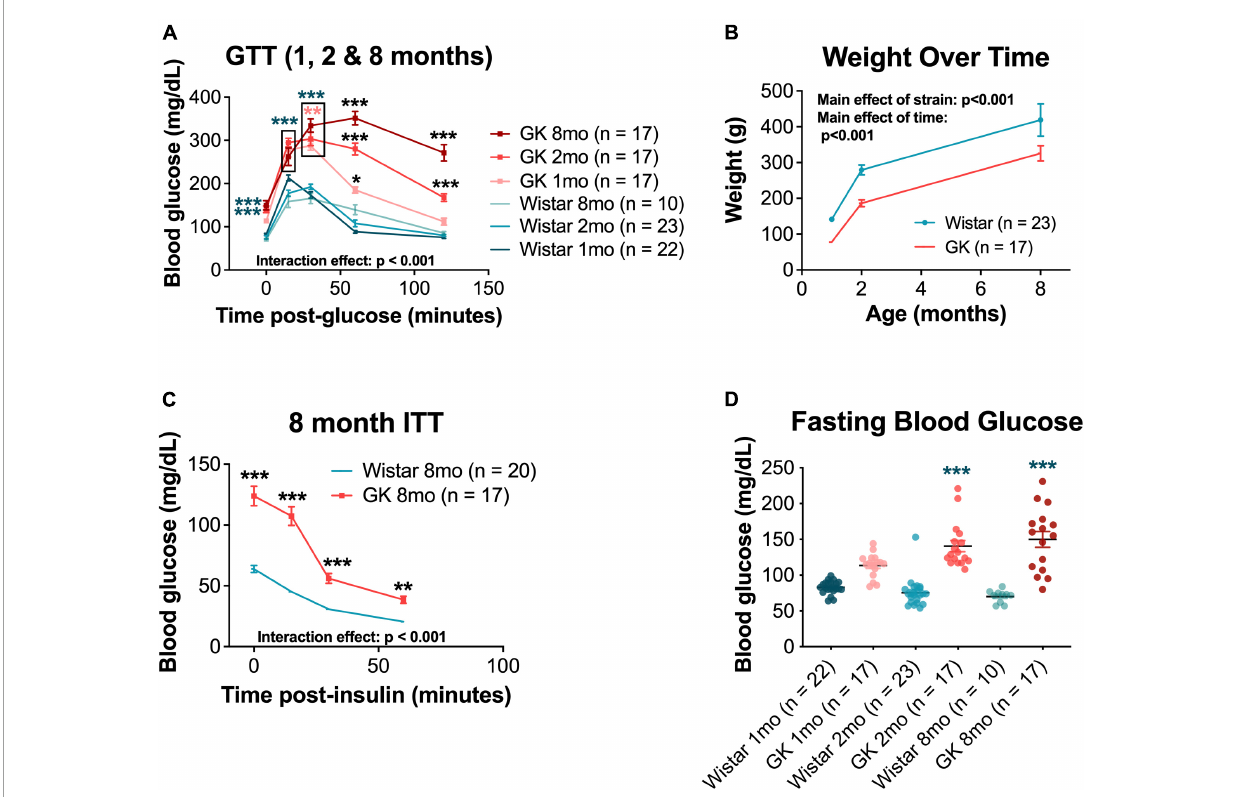
FIGURE1 Goto-Kakizaki (GK) rats exhibit metabolic changes, including impaired glucose and insulin tolerance and reduced body weight. (A) Average blood glucose (mg/dL) at 0, 15, 30, 60, and 120 min post glucose injection for GTT performed at 1, 2, and 8 months of age. (B) Weight (g) at 1, 2, and 8 months of age. (C) Average blood glucose (mg/dL) at 0, 15, 30, and 60 min post insulin injection for ITT performed at 8 months of age. (D) Fasting blood glucose (mg/dL) at 1, 2, and 8 months of age. Black asterisks indicate comparisons between one GK group and all other groups. Blue asterisks indicate comparisons between one GK group and all Wistar groups. Pink asterisks indicate comparisons between GK groups at different ages (A) . * p < 0.05, ** p < 0.01, *** p < 0.001. Results expressed as mean ± SEM.